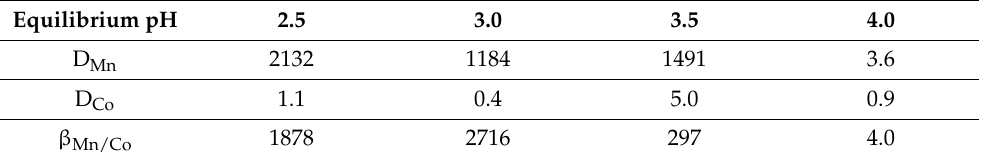
Table 3. The relationship between the equilibrium pH and separation coefficient. Equilibrium pH